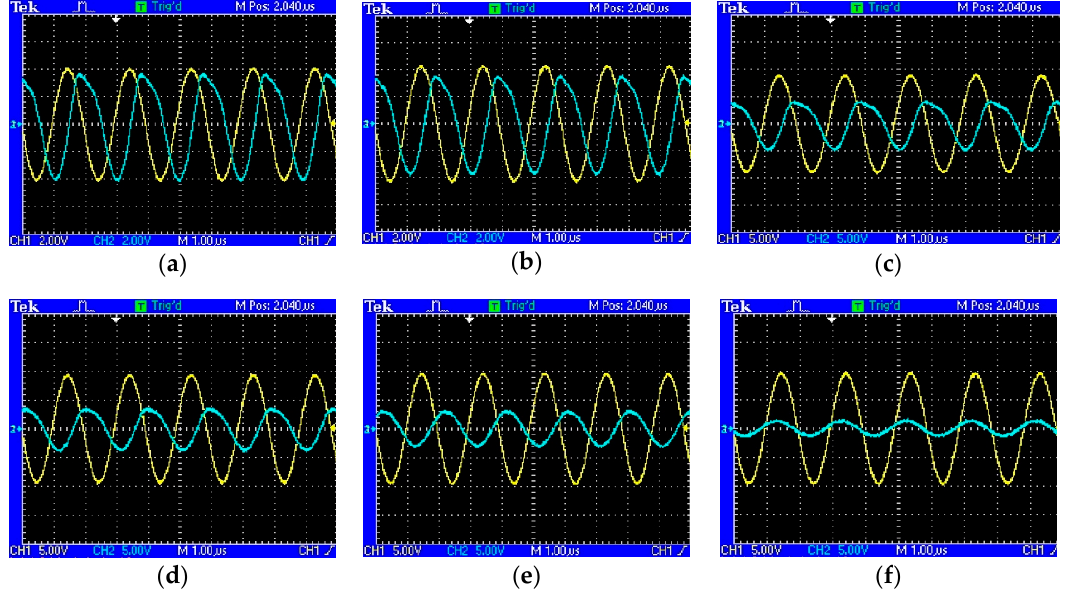
Figure 26. Input (yellow) and output (blue) voltages for the modified hemisphere model with an LED load (V (RMS) = 7.034 V): ( a ) α = 0°; ( b ) α = 15°; ( c ) α = 30°; ( d ) α = 45°; ( e ) α = 60°; ( f ) α = 85°.